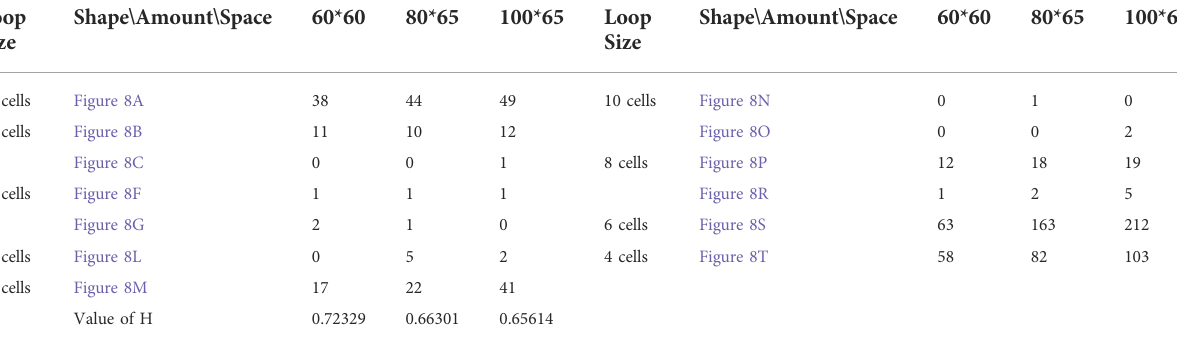
TABLE 3 Statistical numbers of the loops with various structures for the adding mechanism on different cellular spaces starting from the initial con fi guration in Figure 7A. Loop Shape ∖ Amount ∖ Space Size